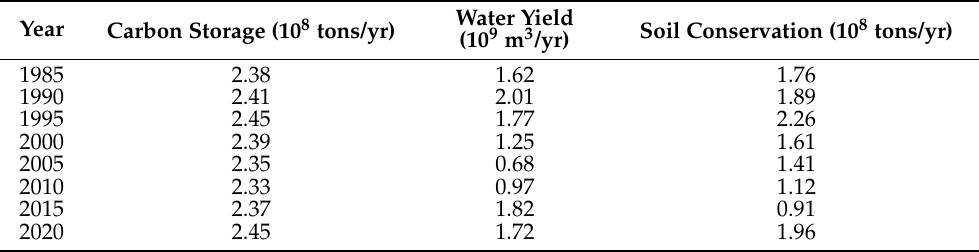
Table 5. The indicator values of multiple ESs from 1985 to 2020 in Beijing. Year Carbon Storage (10 8 tons/yr)